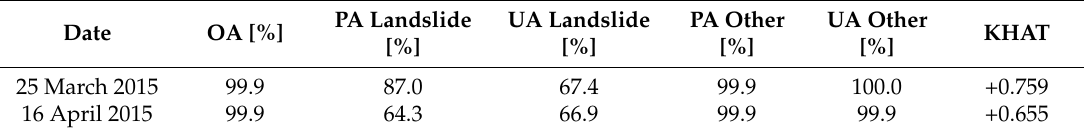
Table 2. Classification accuracies for the Yeager Airport landslide (12 March and 13 April 2015). Overall accuracy (OA), user’s (UA), and producer’s accuracy